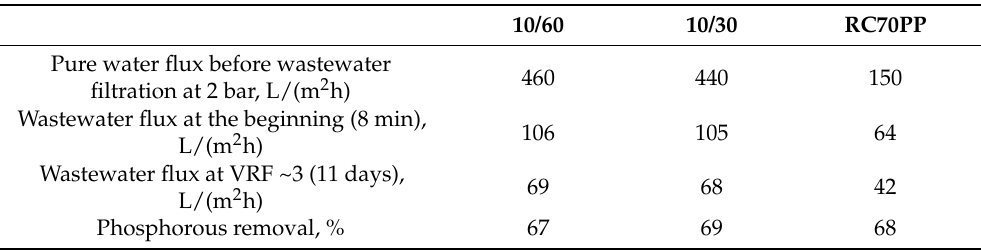
Table 3. Pure water fluxes before and after effluent filtration, and permeate fluxes at the beginning and the end of the concentration